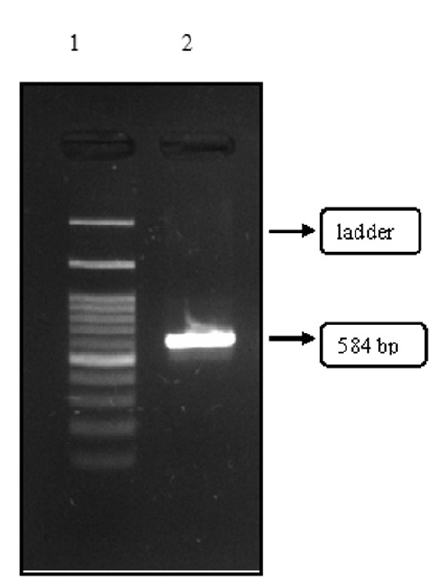
Fig. 7. PCR amplification- the 26 s r DNA gene yielded a 584 bp PCR